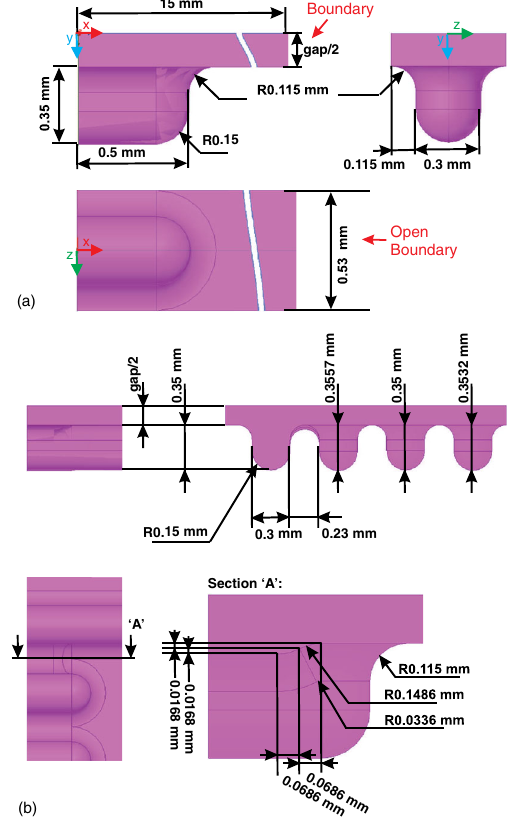
FIG. 2. Geometry of one-quarter of the vacuum part of the regular cell (a) and of the rf power coupler of the structure